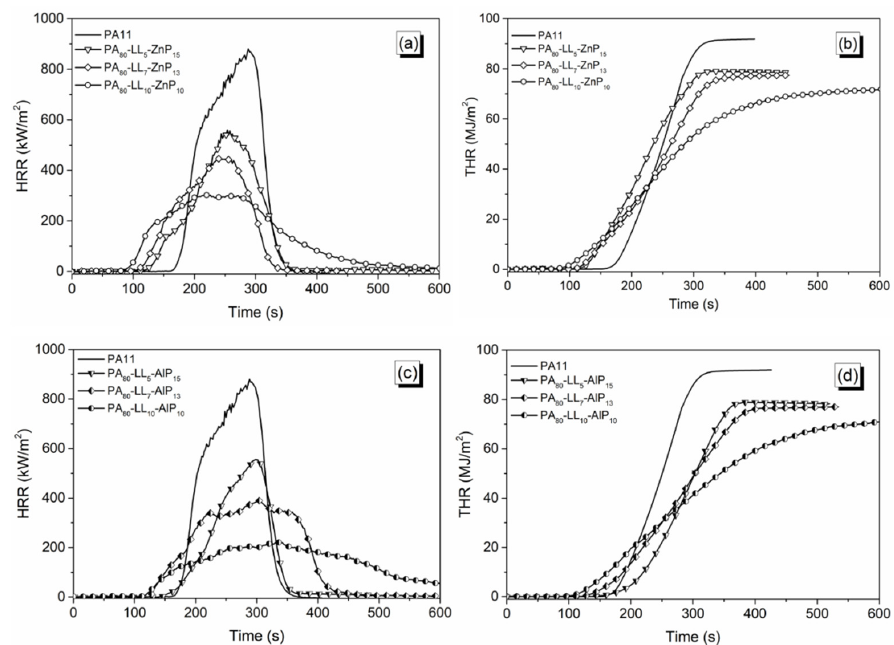
Figure 7. Heat release rate (HRR) and total heat release (THR) curves of polyamide 11 (PA11) blends. ( a ) and ( b ) for PA–LL–ZnP blends; ( c ) and ( d ) for PA–LL–AlP blends. ( a ) and ( b ) for PA–LL–ZnP blends; ( c ) and ( d ) for PA–LL–AlP